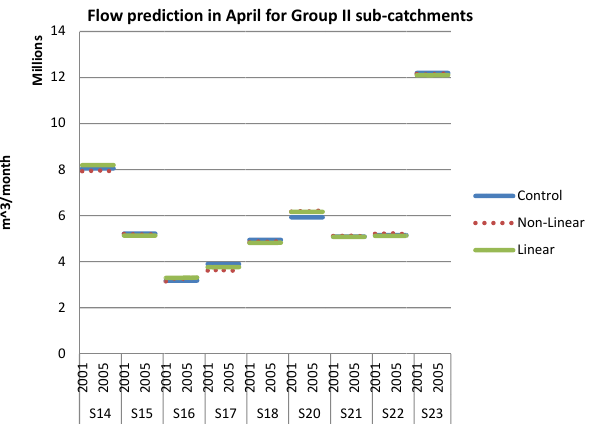
Fig. 8. Predicted flows for April in Group II sub-catchments.